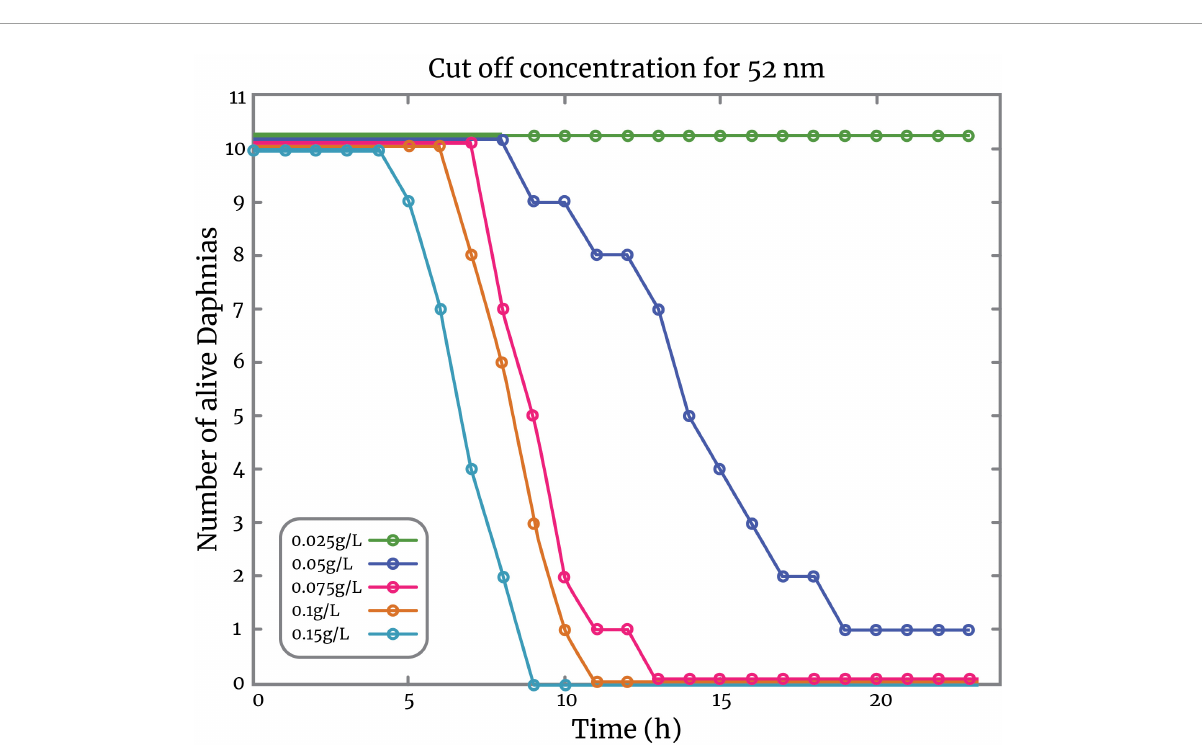
FIGURE2 Example of question from unit on “Life below water” (SDG 14). Based on research presented in a scientific paper (Mattsson et al., 2017), students learn about the effect of micro-plastics on the marine food